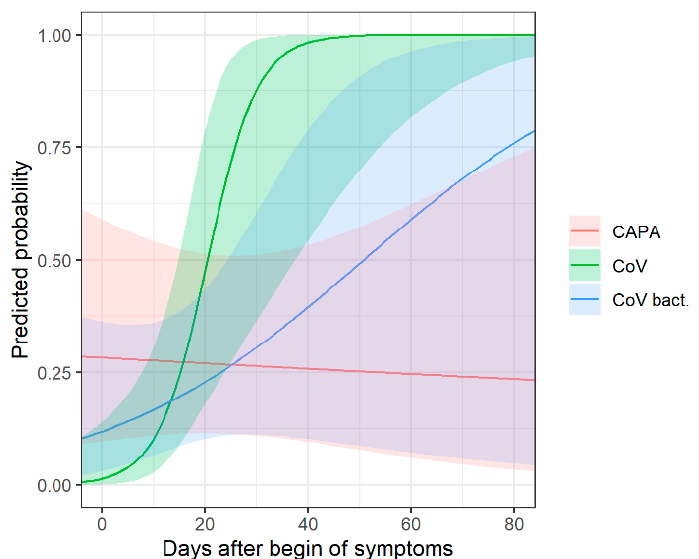
Figure 4. Chronological changes in CT (predicted probabilities of consolidation) with corresponding 95% confidence intervals for patients with COVID-19-associated pulmonary aspergillosis (CAPA), COVID-19 without bacterial superinfection (CoV) and COVID-19 with bacterial superinfection (CoV bact.). In early disease, consolidation is most common in CAPA patients and more common in COVID-19 patients with bacterial superinfection compared to patients without bacterial superinfection.